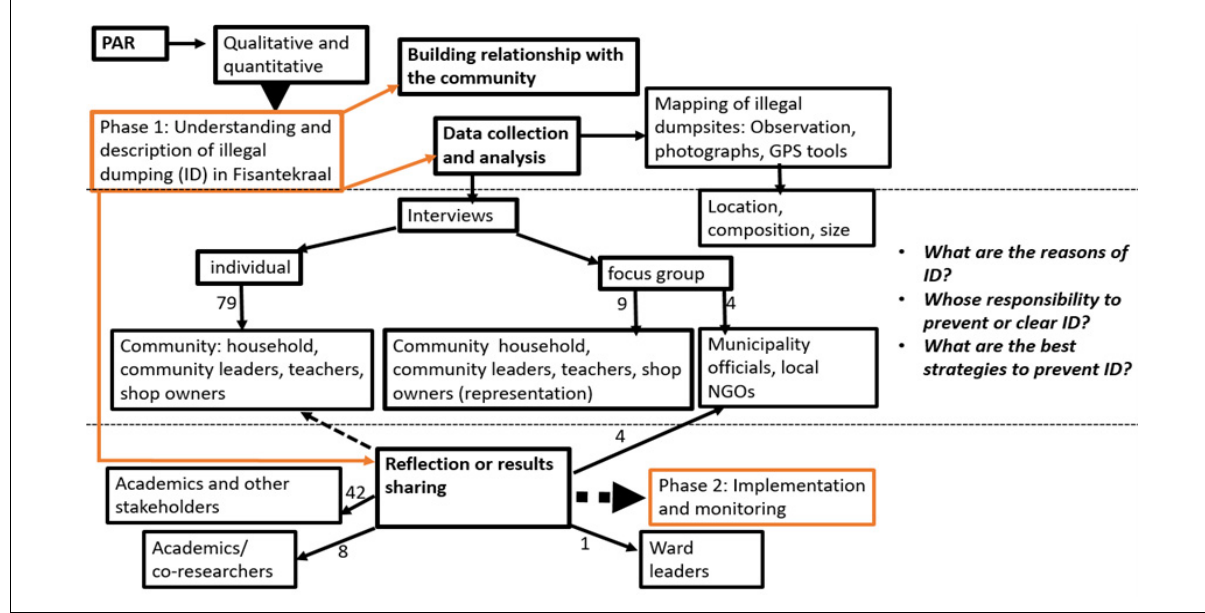
Figure 3: Schematic representation of the participatory action research (PAR)